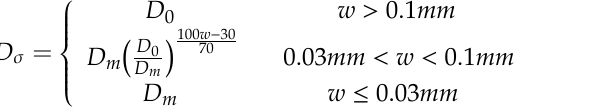
Figure 6. Curve of chloride ion concentration over time.